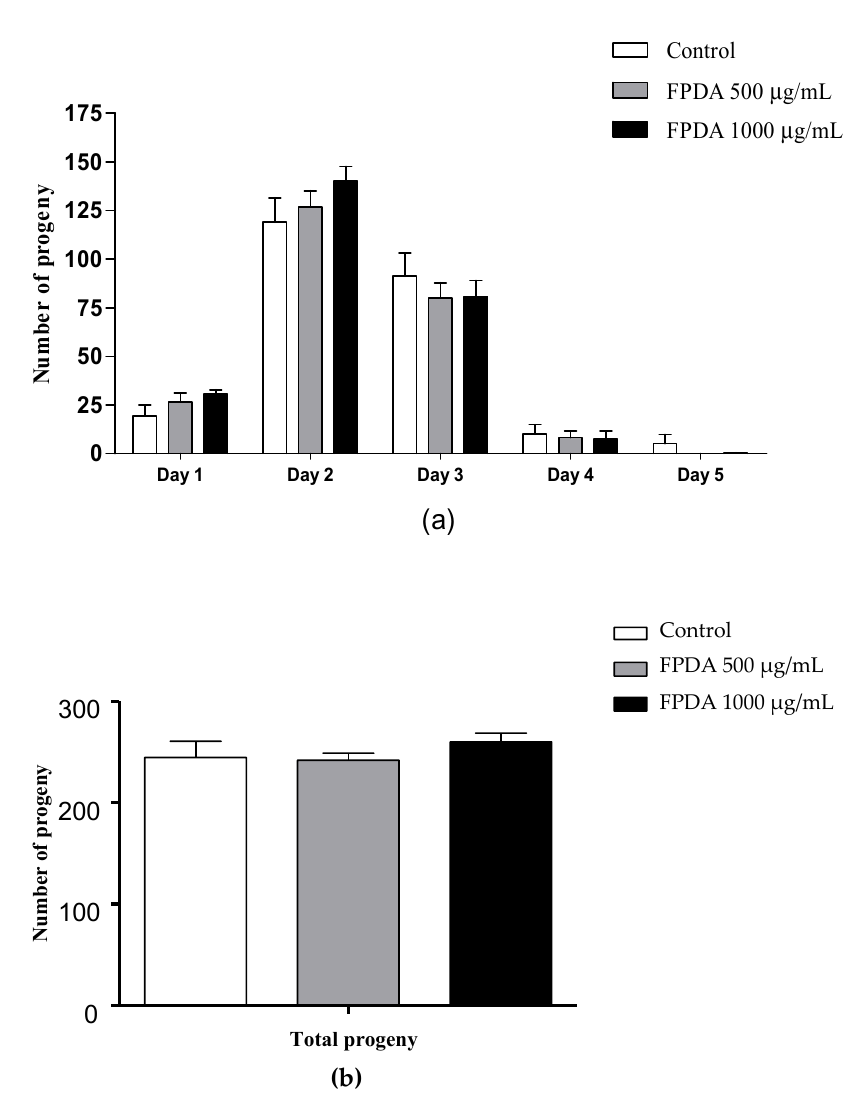
Figure 3. Number of progeny of C. elegans treated with FPDA. ( a ) Daily number of progeny and ( b ) total number of progeny after five days. Values are expressed as the mean ± SEM.